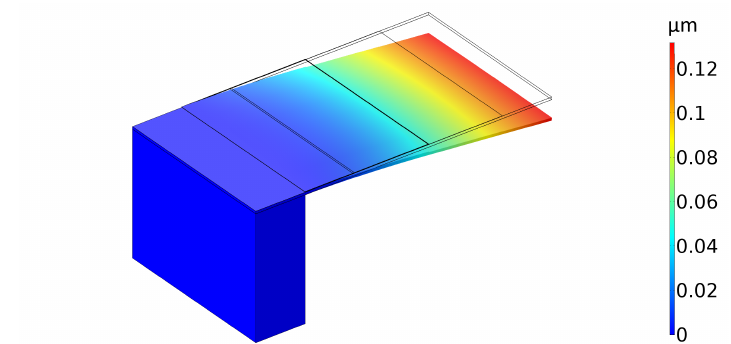
Figure 4. Distribution of applied electric potential on piezoelectric material to simulate the cantilever beam deformation.